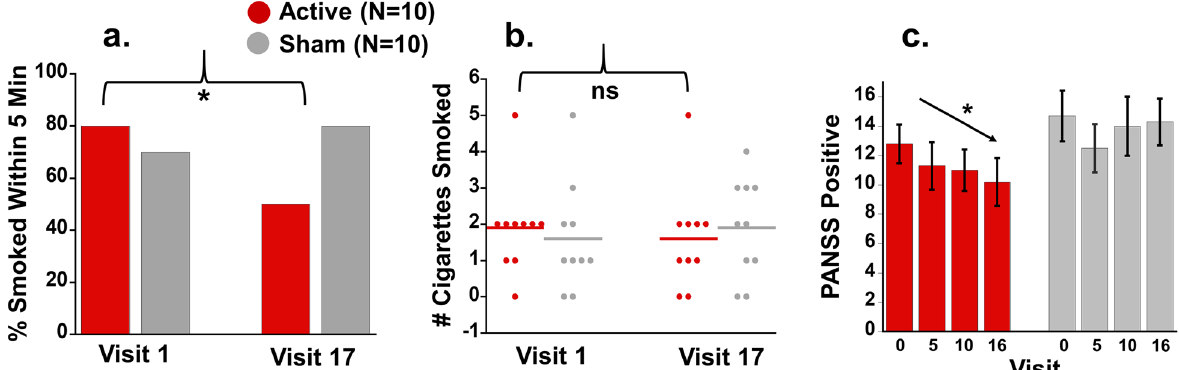
Fig. 3 Effects of dTMS on behavior. a , b In a laboratory task of tobacco choice, participants had the chance to smoke or earn money for abstaining. a There was a signi fi cant interaction on the latency to smoke a fi rst cigarette, where patients in the active dTMS group took longer to smoke after treatment than before it (signi fi cant effect of Visit in this group indicated by asterisk). b While there was a similar direction of effects regarding the total number of cigarettes smoked during the task, no main effects or interactions were signi fi cant (ns = not signi fi cant). In addition to these smoking variables, c dTMS improved severity of psychosis, as measured by the Positive and Negative Syndrome Scale (PANSS). Uniquely in the active dTMS group, there was a linear decrease in positive symptoms over the course of the study (signi fi cant linear contrast indicated by